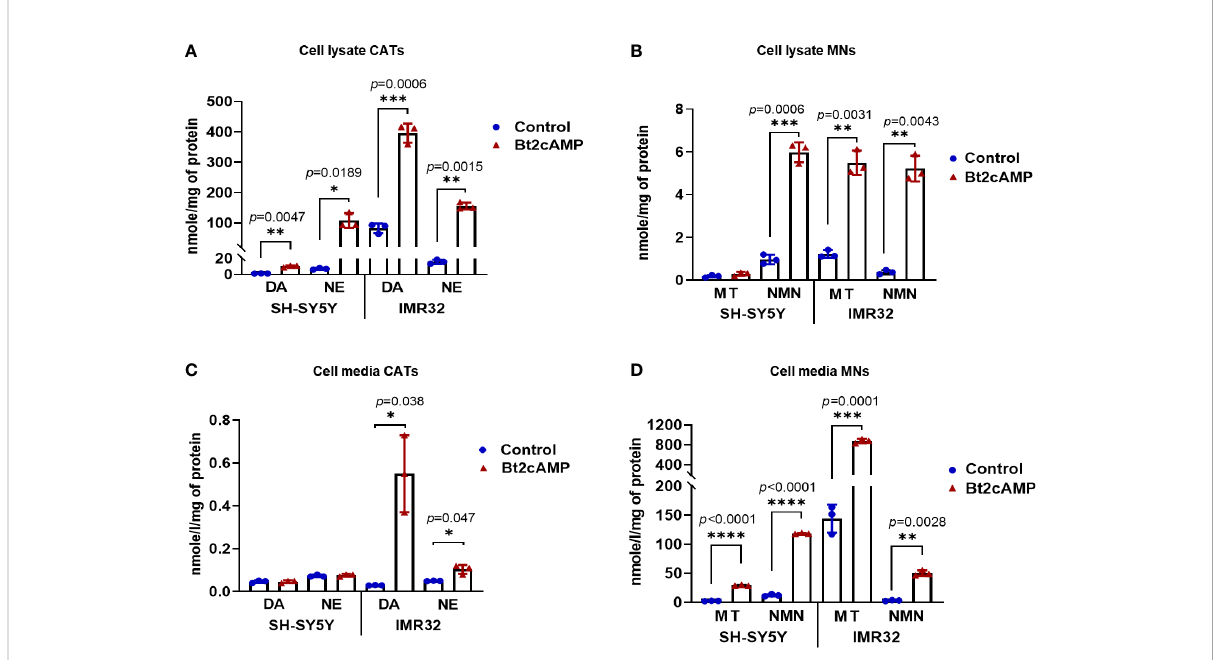
FIGURE 5 Induction of CATs synthesis through Bt2cAMP treatment of NB cells. Concentrations of CATs and MNs in SH-SY5Y and IMR32 cell lysates (A, B) and cell culture media (C, D) after 4 days with or without Bt2cAMP incubation. Assays were performed in triplicate and corresponding values are plotted in the graph with mean and SD. (A) CATs: SH-SY5Y: DA: 10.21 vs 1.14 nmol/g (treated vs control), NE: 107.5 vs 6.82 nmol/g; IMR32: DA: 395.5 vs 82.13 nmol/g, NE 155.43 vs 15.67 nmol/g, respectively. (B) MNs: SH-SY5Y: MT: 0.29 vs 0.19 nmol/g, NMN: 5.98 vs 0.97 nmol/g; IMR32: MT: 5.49 vs 1.22 nmol/g, NMN: 5.22 vs 0.37 nmol/g, respectively. (C) CATs: IMR32: DA: 0.55 vs 0.03 nmol/g, NE 0.1 vs 0.05 nmol/g, respectively (D) MNs: SH-SY5Y: MT: 29.37 vs 2.65 nmol/g, NMN: 118.75 vs 12.29 nmol/g; IMR32: MT: 877.89 vs 144.35 nmol/g, NMN: 50.49 vs 3.29 nmol/g. Individual values and means ± SD are plotted and analyzed with a Welch ’ s t-test. p values are reported only when statistically signi fi cant (<0.05), *= p <0.05, ***= p <0.001, ****= p